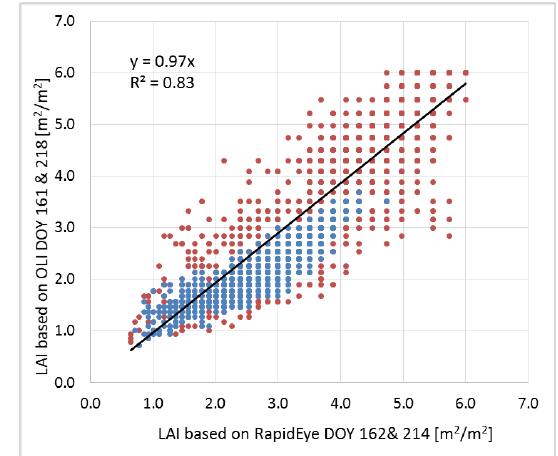
Figure 6: Comparison of LAI retrieval based on Landsat OLI/ETM+ and RapidEye data for the two dates analysed (blue: DOY 161, red: DOY